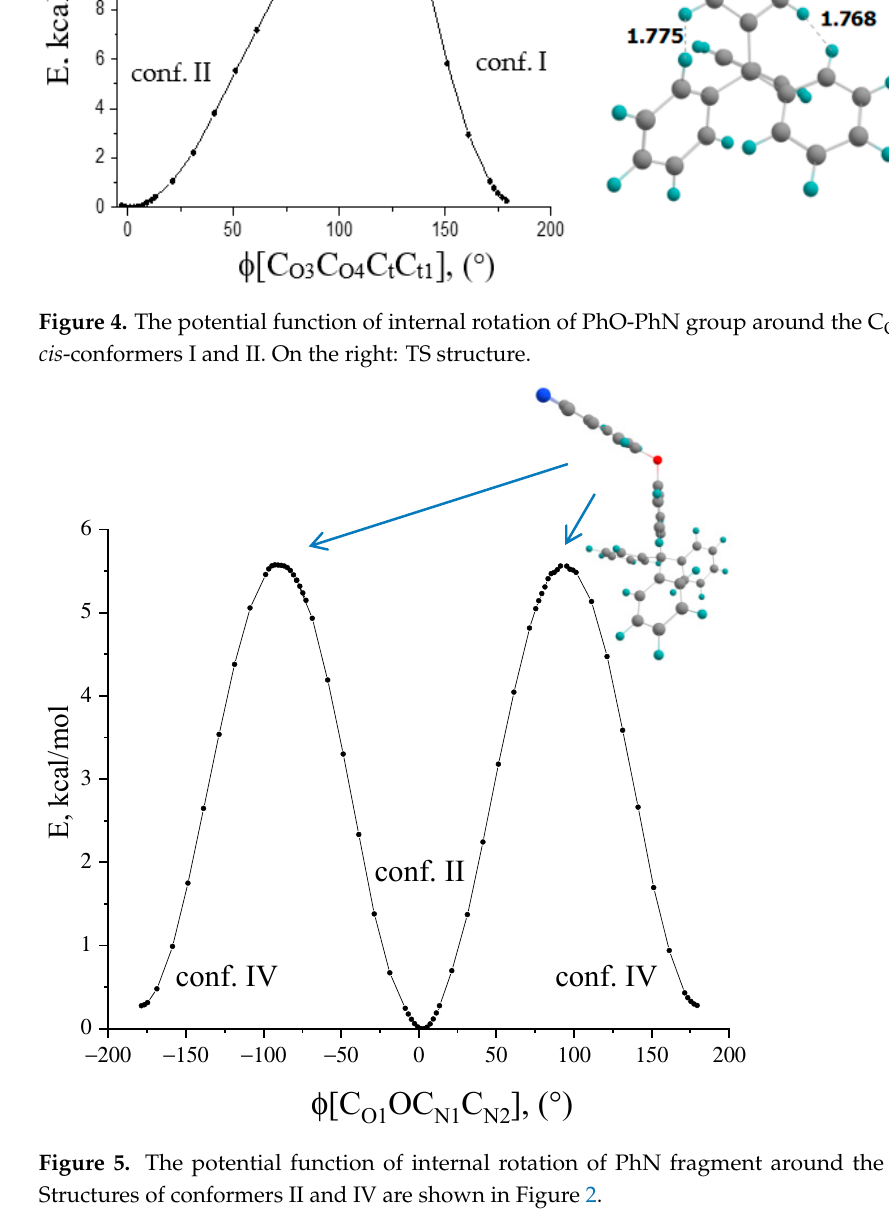
Figure 5. The potential function of internal rotation of PhN fragment around the C N1 -O bond. Structures of conformers II and IV are shown in Figure 2.